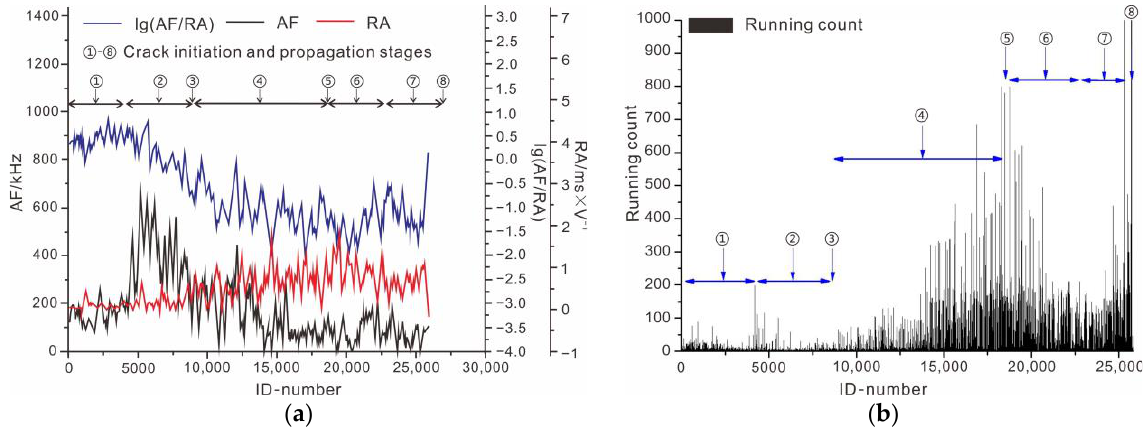
Figure 8. Parameters of acoustic emission of intact rock sample. ( a ) Curve of parameters of acoustic emission; ( b ) running count of intact rock sample.